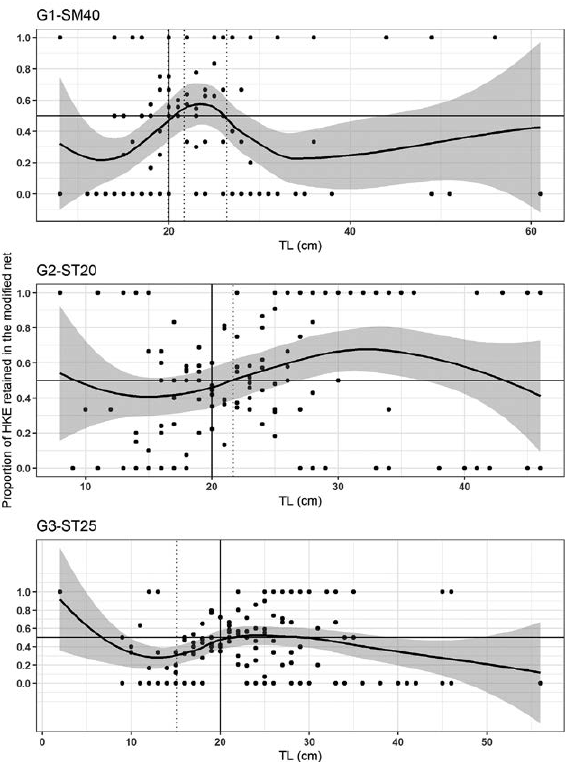
Fig. 5. – Proportion of fish retained in trawl nets equipped with JT- EDs (=JTED/(JTED+ control) vs. length for European hake (HKE). The value of 0.5 means both gears catch equal numbers,the solid line gives the mean, and the grey band gives the 95% confidence limit. MCRS (DPS, 20 mm; HKE, 20 cm). G1-SM40, JTED cov- ered with a net of 40-mm square mesh; G2-ST20, JTED with steel bars spaced 20 mm; G3-ST25, JTED with steel bars spaced 25